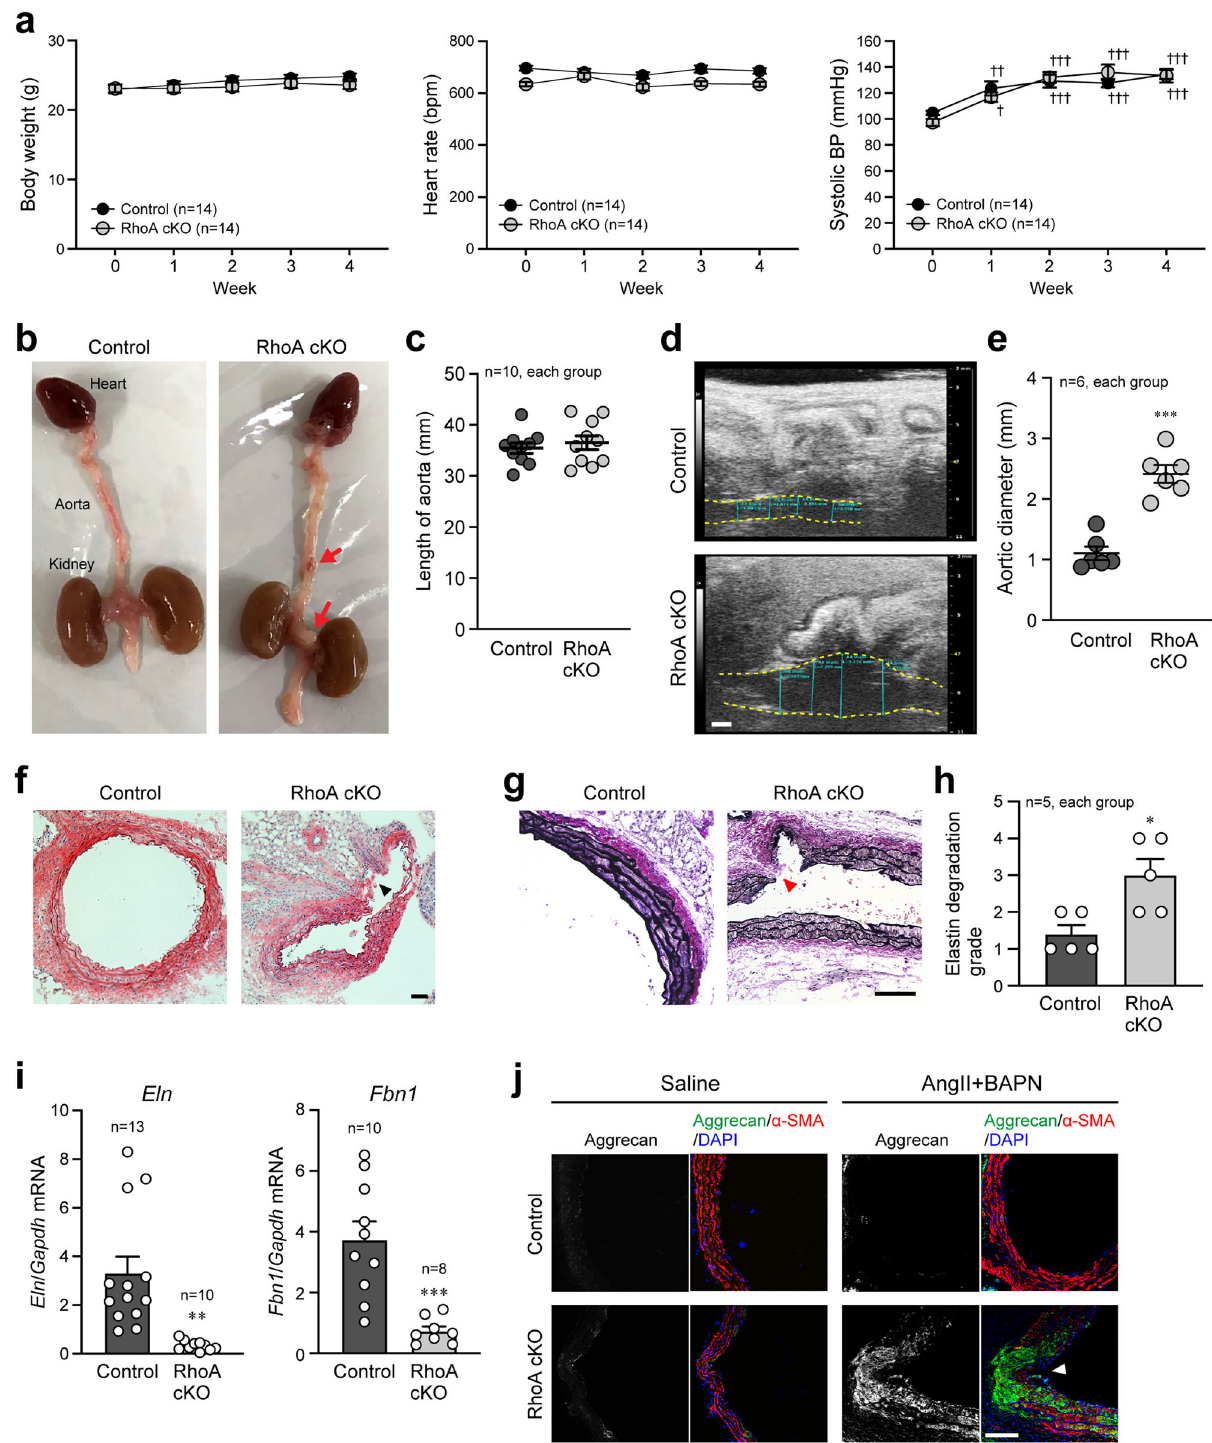
Fig. 2 Induction of AAA in RhoA cKO mice treated with AngII and BAPN. a Changes in body weight and hemodynamics before (Week 0) and after treatment with AngII and BAPN. n = 14, each group. b External appearance of the aorta with the heart and kidneys extracted after the 4-week treatment. Arrows indicate formed AAA. c Length of aorta from the aortic valve to the common iliac artery bifurcation. d Ultrasonographic observation of the abdominal aorta, which is outlined by yellow dotted lines, after the treatment. e Summary graph of the abdominal aortic diameter. n = 6, each group. f H-E staining of the aorta. g Verhoeff Van Gieson staining of the aorta. h Summary graph of the elastin degradation grade analyzed in ( g ). n = 5, each group. i qPCR analysis of genes related to aortic elasticity. n = 13 in Control and n = 10 in RhoA cKO for Eln , and n = 10 in Control and n = 8 in RhoA cKO for Fbn1 . j Co-immunostaining of aggrecan and α -SMA in the mouse aorta after the treatment. Nuclei were counterstained with DAPI. Arrowheads: position of AAA rupture ( f , g , j ). Scale bars: 1 mm ( d ) and 100 μ m ( f , g , j ). In ( a ), two-way or one-way ANOVA was applied to compare the data between groups and weeks, respectively, and in ( c , e , h , i ), the data between the two groups were analyzed by t -test. † p < 0.05, †† p < 0.01, and ††† p < 0.001 vs. Week 0; * p < 0.05, ** p < 0.01, and *** p < 0.001 vs. Control. COMMUNICATIONS BIOLOGY| (2022) 5:1071